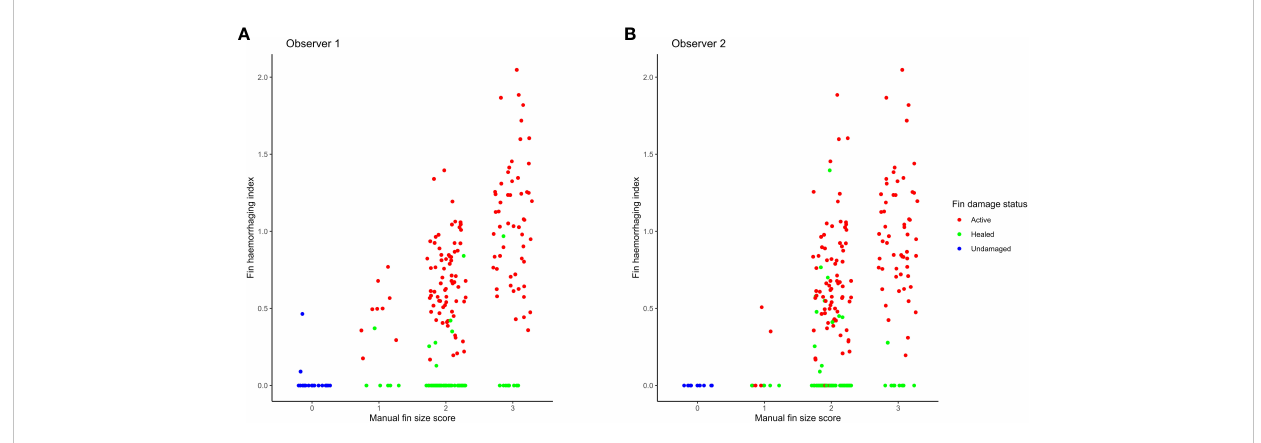
FIGURE 5 Fin haemorrhaging index relative to manual fi n size scores, colored according to injury status, for observer 1 (A) and observer 2 (B)